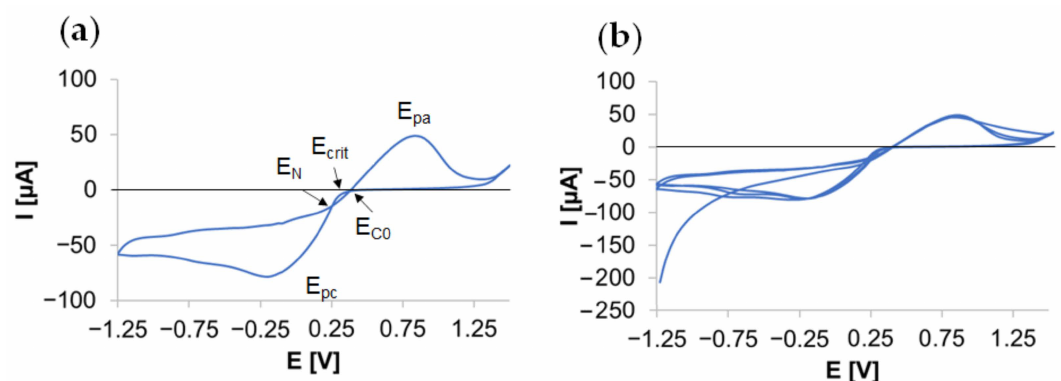
Figure 2. Cyclic voltammogram measured in 1 mM AgNO 3 solution at a scan rate of 50 mV/s of a three-electrode system using annealed TNTs as the working electrode, silver chloride electrode (E Ag/AgCl (3 M KCl) = 0.222 V vs. SHE) as the reference electrode, and Pt mesh as the auxiliary electrode ( a ) and three subsequent CV cycles ( b